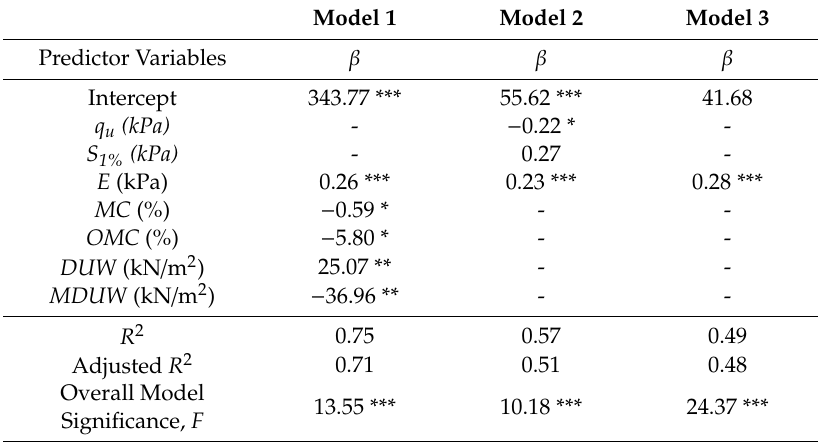
Table 3. Developed resilient modulus